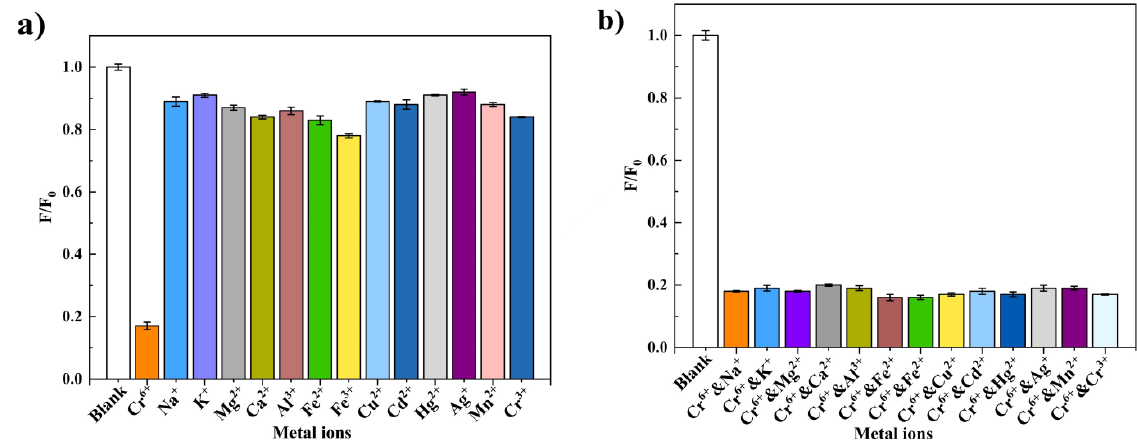
Figure 4. ( a ) The relative fluorescence intensity (F/F 0 ) of Si,N-CQDs is added with various metal ions of 500 µ M. ( b ) The relative fluorescence intensity (F/F 0 ) of Si,N-CQDs-Cr(VI) system added with 500 µM various anions.